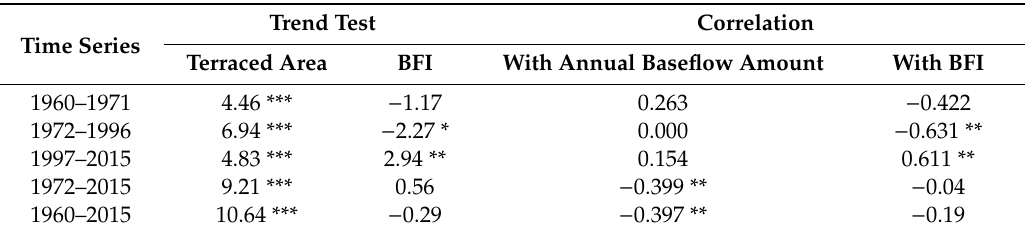
Table 6. Change trend of terrace area in Dali River Basin in di ff erent periods and its correlation with annual baseflow amount and